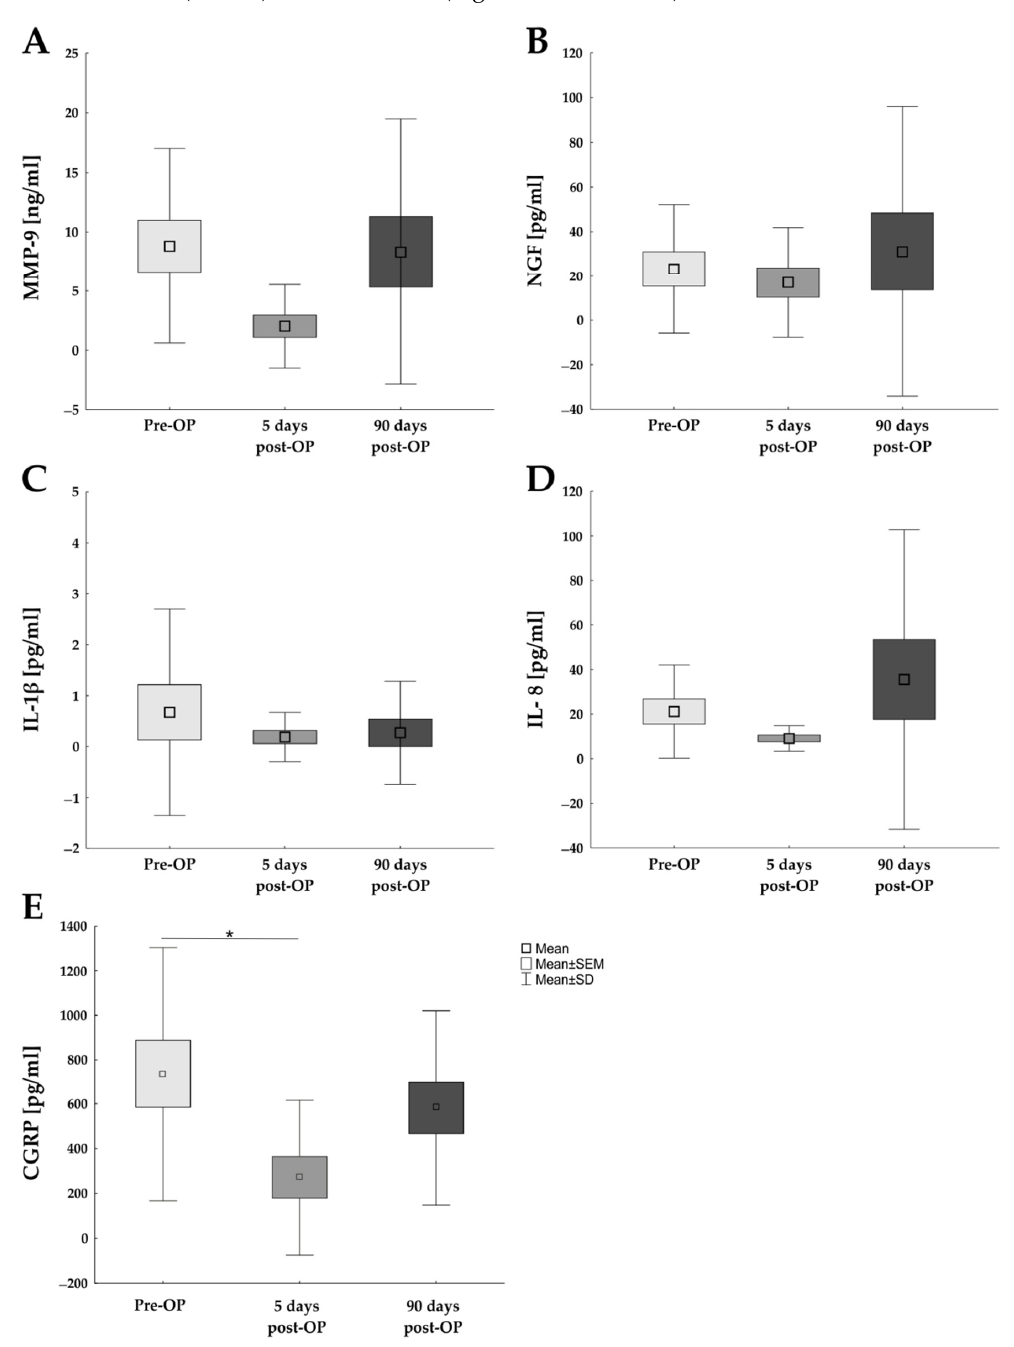
Figure 2. Protein expression in tear film before and after Femto-LASIK. ( A ) Evaluation of MMP-9 values pre-OP as well as 5 and 90 days after Femto-LASIK revealed no significant